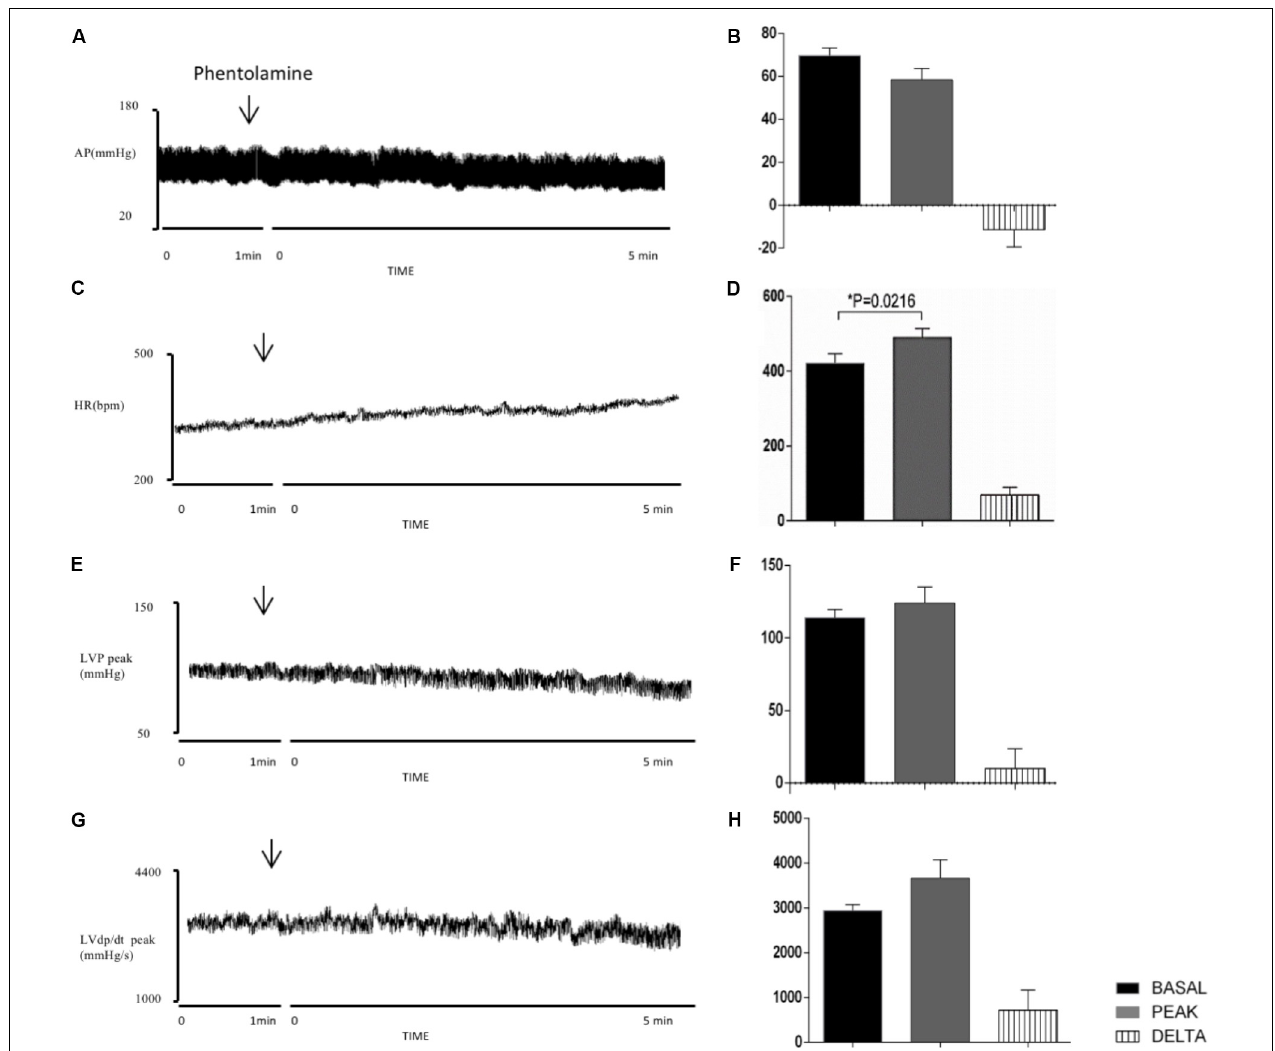
FIGURE 5 | Left column – Chart records illustrating the responses of MAP (A) , HR (C) , LVP peak (E) , and LVdP/dt peak (G) produced by the unilateral microinjection of phentolamine in PVN (arrows indicate the moment of injection). Right column – Mean maximal changes in MAP (B) , HR (D) , LVP peak (F) , and LVdP/dt peak (H) in response to unilateral microinjections of phentolamine (100 nl). Values refer to the means collected in the basal period (2 min before the central injection), and at the maximum point of response to microinjection and its variation. ∗ P < 0.05. MAP, mean arterial pressure; HR, heart rate; LVP peak, maximum pressure in the left ventricle; LVdP/dt peak, first derivative of cardiac left ventricle pressure. n =